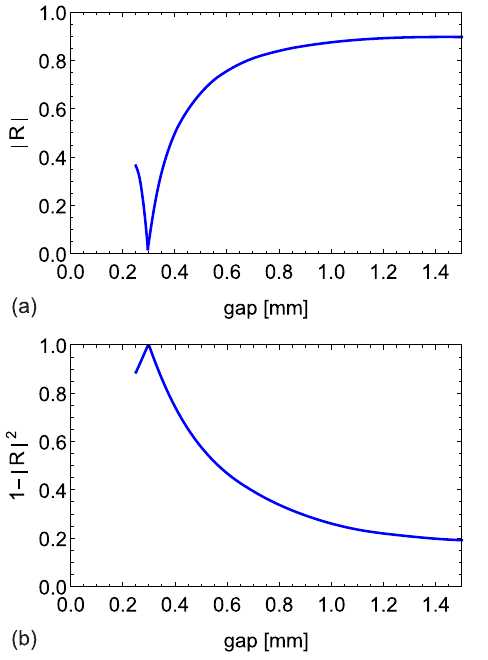
FIG. 3. Coupler reflection (a) and power transmission (b) as a function of the gap aperture, calculated with the coupler matched at the 0.3 mm